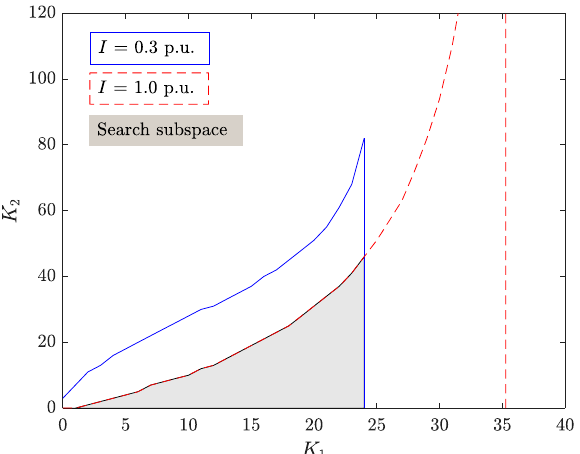
Figure 9. Feasible search subspace for PSO to determine K 1 and K 2 for K 3 = 0.